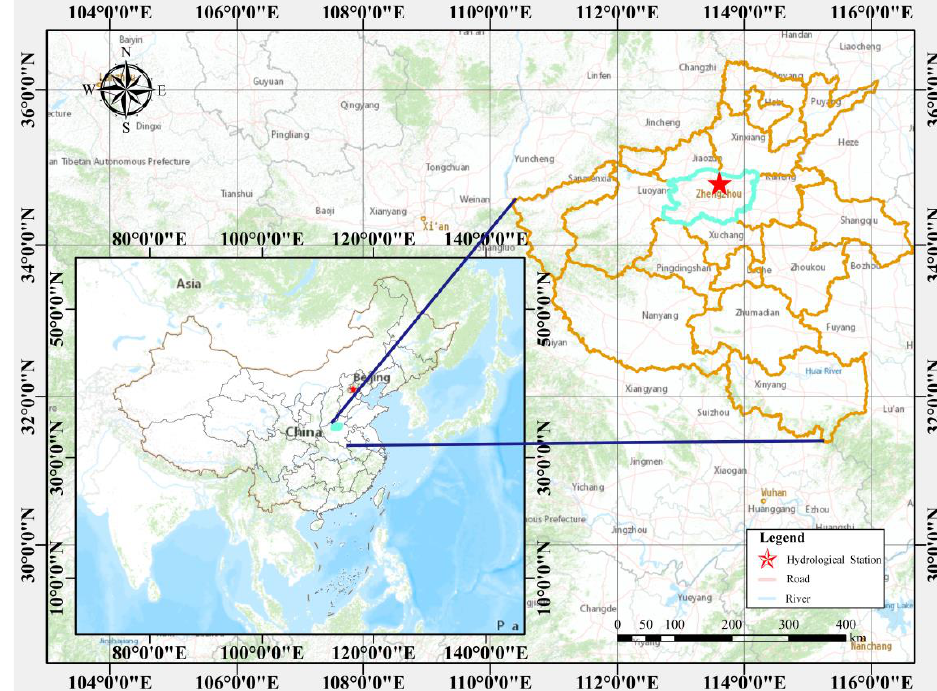
Figure 3. Location map of the study area.